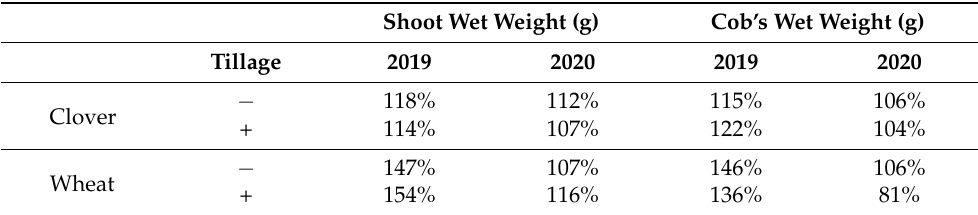
Table 7. Comparative analysis of the 2019 and the 2020 experiments plants’ growth and yield results at the harvest day 1 .